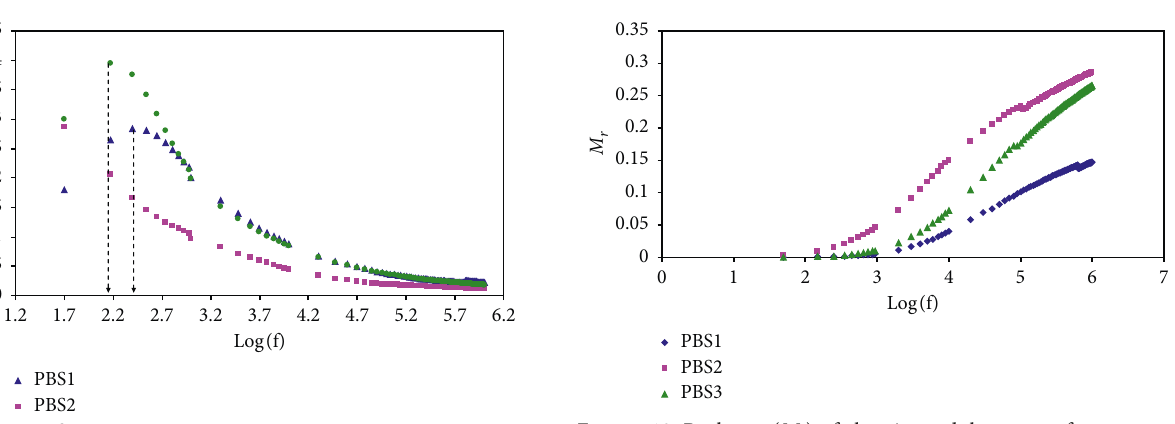
Figure 10: Real part ( M r ) of electric modulus versus frequency at ambient temperature for CS:POZ blend